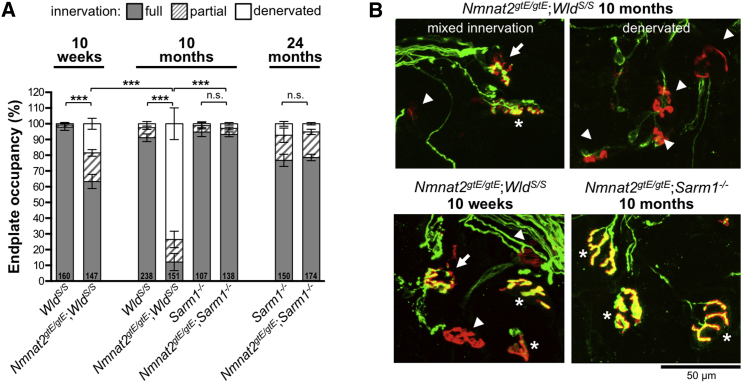
Progressive Loss of NMJ Innervation in Gastrocnemius Muscles of Nmnat2gtE/gtE;WldS/S Mice, but Not Nmnat2gtE/gtE;Sarm1−/− Mice(A) Percentage of fully occupied (full), partially occupied (partial), and denervated endplates in gastrocnemius muscles from mice of the indicated genotypes and ages. Endplate occupancy was determined by assessing signal overlap between α-bungarotoxin labeling of acetylcholine receptors in the motor endplate and βIII-tubulin immunostaining of axon terminals (see Experimental Procedures). Total numbers of NMJs analyzed in muscles from 3–5 mice per genotype (male and female) are listed at the base of each column. Means ± SEM of occupancy per animal are plotted (NS, not significant [p > 0.05] or ∗∗∗p < 0.001 in one-way ANOVA with Tukey’s multiple comparisons of full innervation, selected comparisons).(B) Representative confocal z series projections of fixed gastrocnemius (Gn) muscle preparations showing merged α-bungarotoxin (red) and βIII-tubulin (green) signals. Endplates in the images are marked as fully occupied (asterisks), partially occupied (arrows), or denervated (arrowheads).